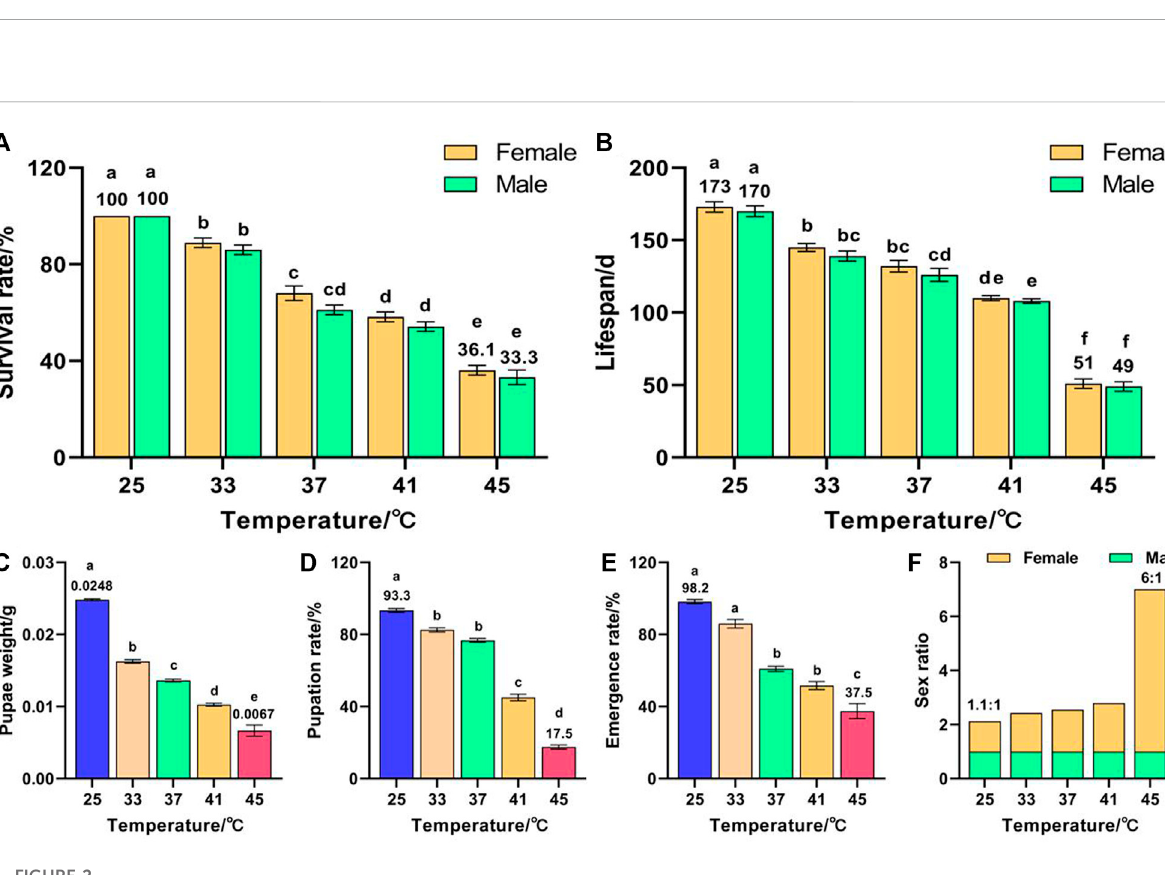
FIGURE 1 Effects of short-term high temperature on survival and lifespan of Z. cucurbitae (F 1 ). (A) Survival rate. (B) Lifespan. The columns in the fi gure represent the mean ± standard error, and the letters above them indicate signi fi cant differences ( p ≤ 0.05).